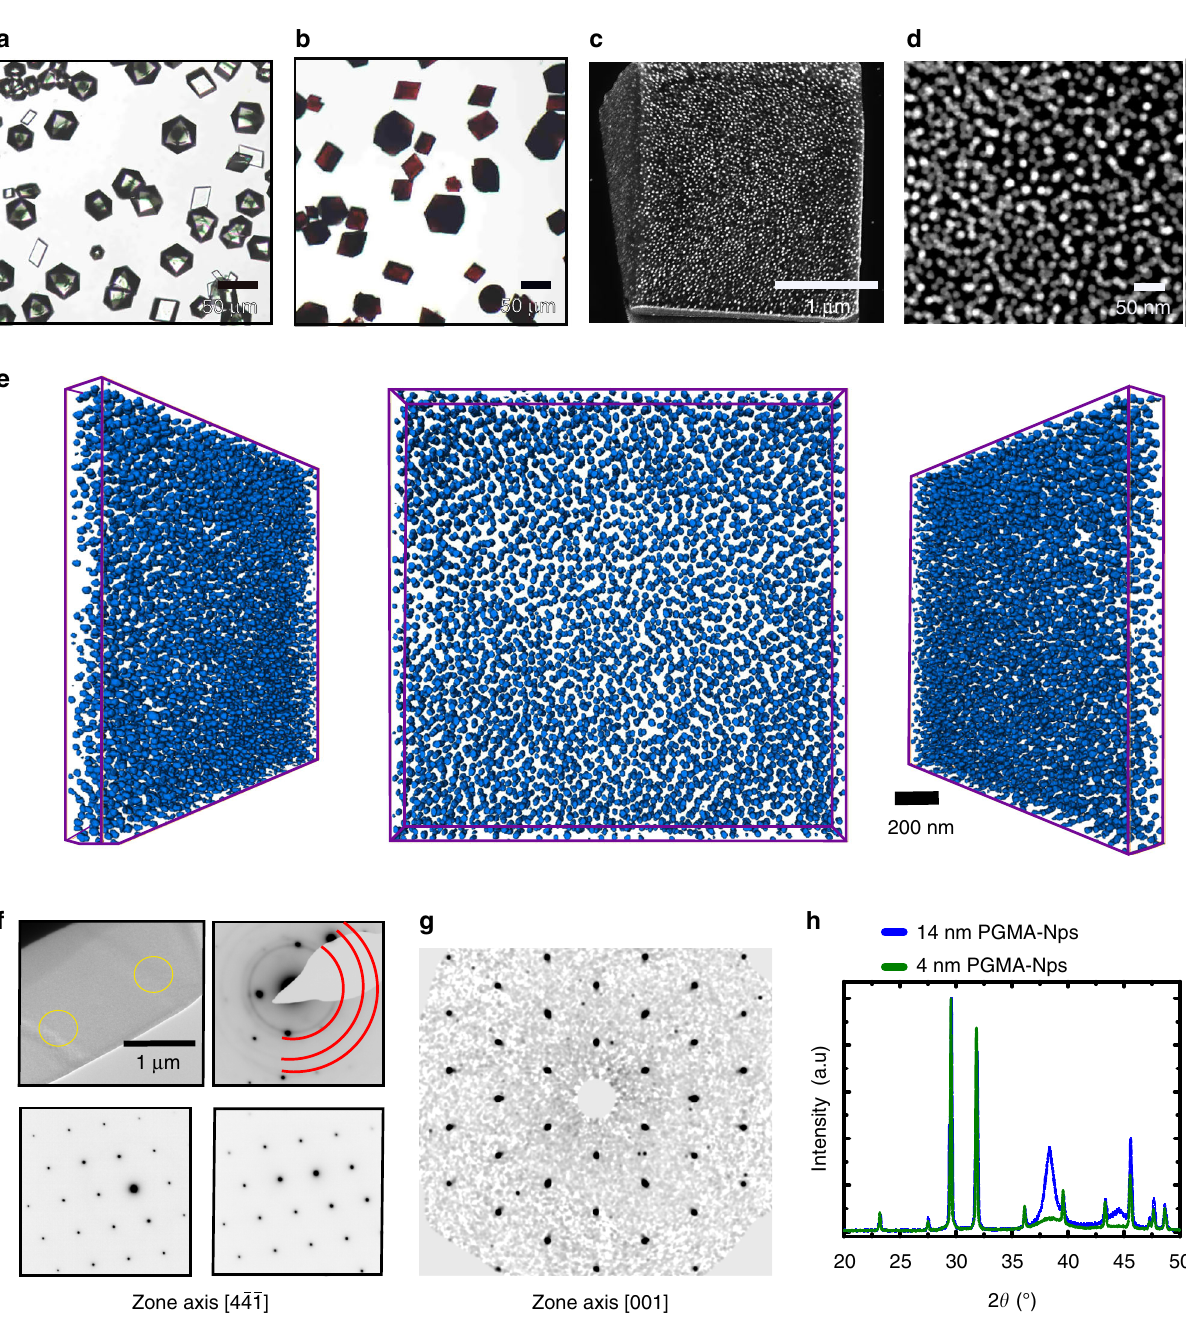
Fig. 4 Calcite crystals precipitated in the presence of PGMA and 14 nm PGMA-NPs. a Optical micrograph of crystals grown in the presence of 1 wt% PGMA polymer only. b – h Analyses of crystals precipitated in the presence of 0.05 wt% of PGMA-NPs. b Optical micrograph, c SEM image of FIB cross- section and d STEM HAADF image of a lamellar cut from a crystal. e Segmented STEM tomograms of a sectioned lamella from a representative crystal shown perpendicular to the lamella and at two angles. f A low-magni fi cation TEM image of a sectioned lamella from a crystal and the corresponding selected area electron diffraction (SAED) pattern, recorded off the zone axis, to enable diffraction rings from the gold NPs to be readily observed. Two further SAED patterns from the areas indicated are also shown, demonstrating the single crystal structure. g Single crystal diffraction pattern (recorded with a single crystal diffractometer) taken from a crystal ≈ 70 μ m in size. The reconstructed (unwarped) layer of the diffraction pattern along the [0 0 1] direction is shown, where this was obtained by full rotations of the crystal. h Lab powder XRD diffractograms of PGMA-NP/calcite nanocomposite crystals containing 4 and 14 nm occlusions. The presence of organics is associated with an occlusion a zone arising from the interface between the NP and increase in the lattice spacings, where this is greatest along the crystal matrix becomes signi fi cant. Its behaviour can be c -axis due to the elastic anisotropy of calcite 15 . Calcite crystals considered based on the mechanics of the interface between a NP and the surrounding crystal. This was explored by performing containing low concentrations of stabilised NPs therefore exhibit MD simulations of the lattice distortions resulting from the peak broadening and lattice expansion 10,28 . At very high levels of